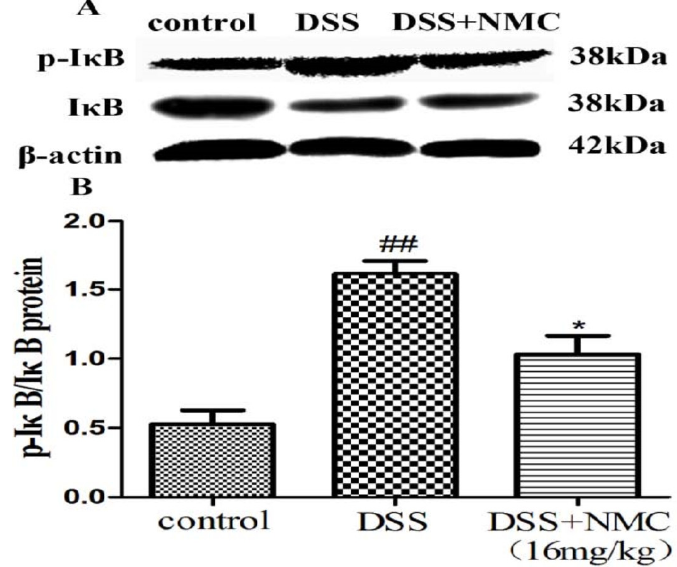
Figure 7. Effects of NMC on the expression of p-IkB and IkB in DSS-induced colitis. ( A ) The expression of p-IkB and IkB in colon tissue were determined using Western blotting. ( B ) The relative quantification of p-IkB and IkB protein expression calculated by using Image J software. Data are expressed as mean ( n = 10 per group) ± SEM. ## p < 0.01 compared with control group; * p < 0.05 compared with the DSS-vehicle group.